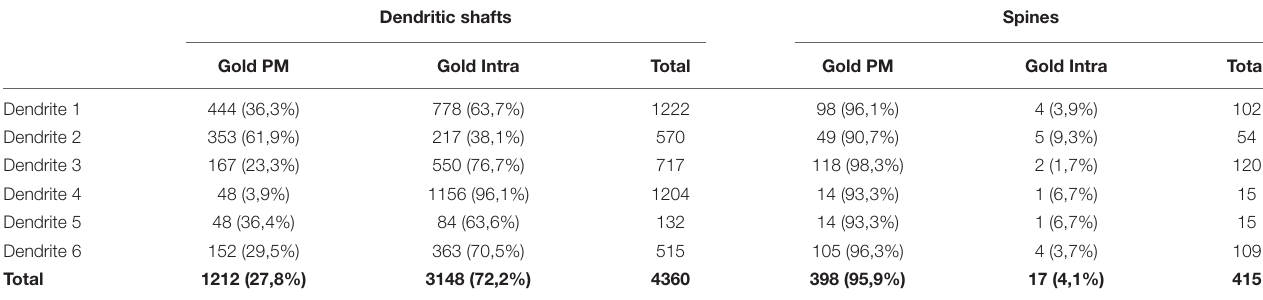
TABLE 1 | Distribution of SK2 immunoparticles on 3D reconstructed dendritic spines and shafts of CA1 pyramidal cells. PM, Plasma membrane; Intra, intracellular. Dendritic shafts